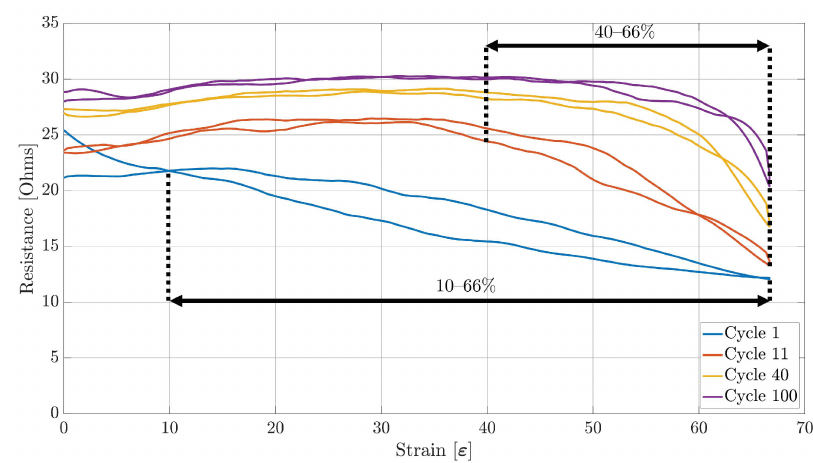
Figure 11. Sensor S3 strain data over the 1st, 11th, 40th, and 100th stretching cycle.